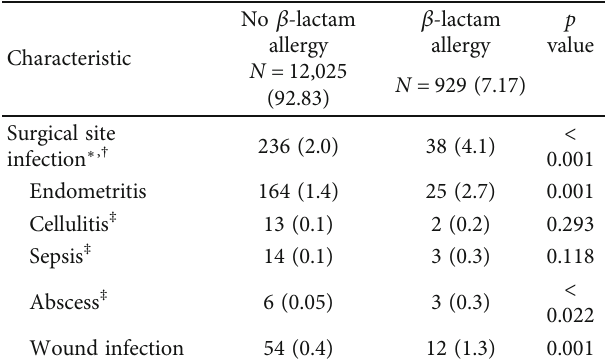
Table 2: Surgical site infection